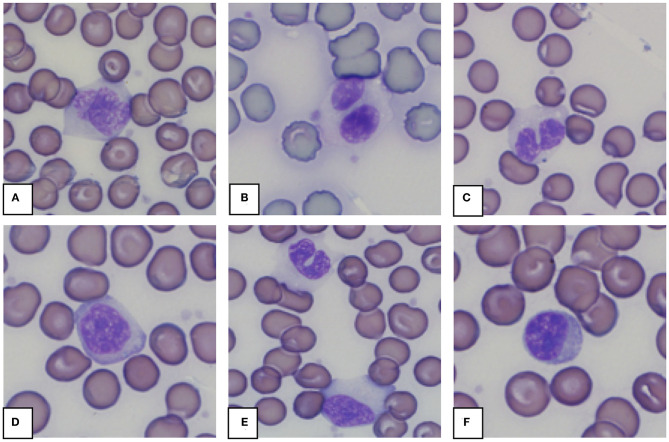
Representative monocytes (A–E) and lymphocyte (F) in blood smears from an African elephant (Loxodonta africana). (A): Normal monocyte; (B,C): Bilobed monocytes; (D): Round monocyte; (E): Normal and bilobed monocyte; (F): Lymphocyte. Wright -Giemsa stain; 1,000x magnification.